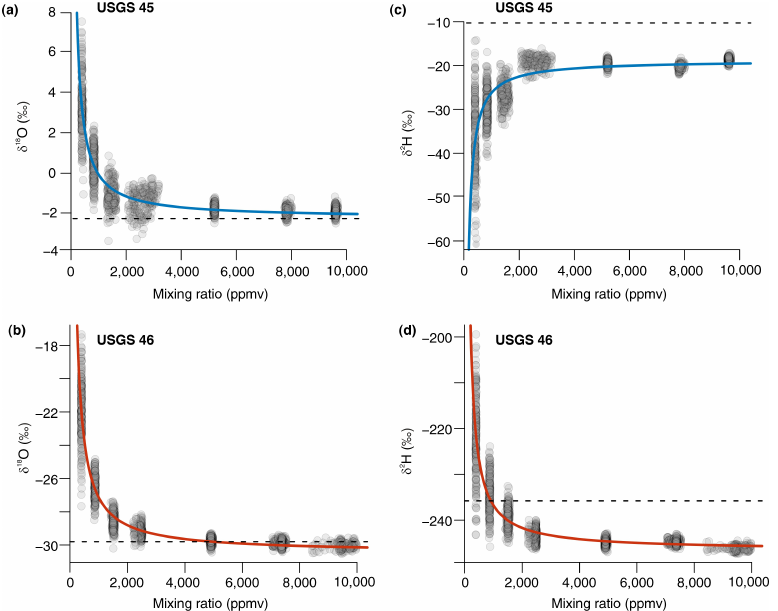
Figure A2. Pallas humidity response calibrations for ( a , b ) δ 18 O and ( c , d ) δ 2 H of USGS standards 45 (blue) and 46 (red). Grey circles represent individual 1-s measurements, and the solid line shows the non-linear regression used to correct ambient isotope data as a function of cavity humidity. Dashed line shows the known isotopic value of the standard